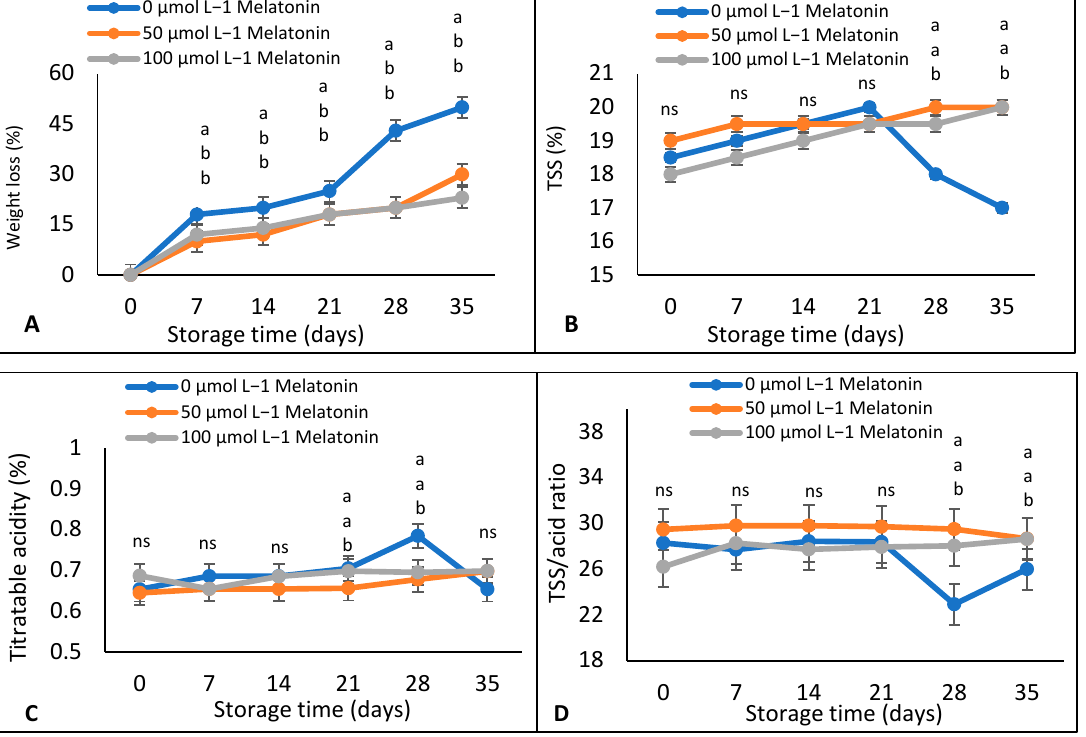
Figure 2. Effect of three concentrations of melatonin on ( A ) weight loss, ( B ) TSS, ( C ) titratable acidity, and ( D ) TSS: acids ratio of grape berries stored at 0 °C for 35 days. Values are means ± SE from five replicates ( n = 5). The same letter means no significant differences between the values ( p < 0.05) according to the Tukey test.